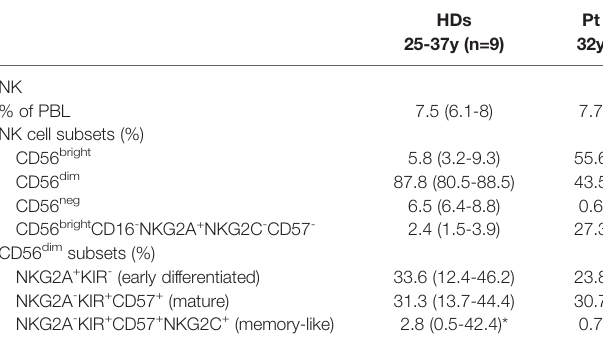
Values are indicated as median (IQR, interquartlile range). *1.7(0.1-6) and 25(2.5-80) in CMV-seronegative and -seropositive subjects, respectively (22). y,